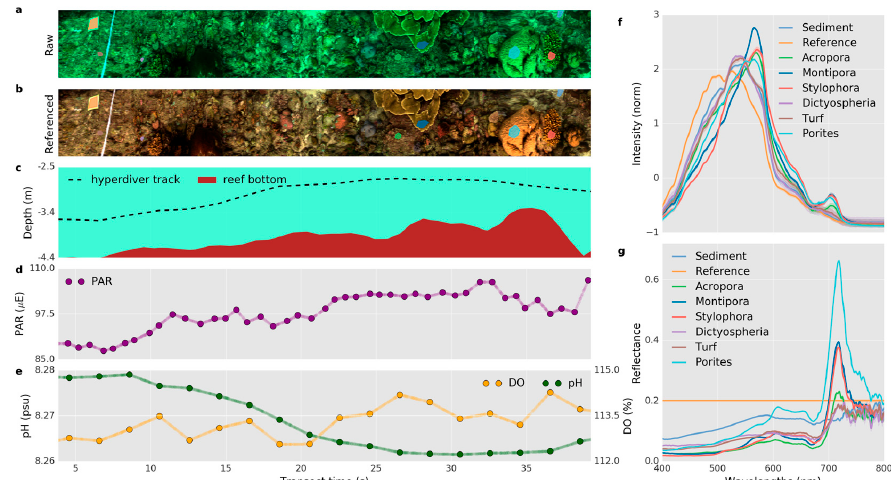
Figure 4. A multi-faced dataset from HyperDiver. ( a ) Three-channel color image; ( b ) a true-color image after correction; ( c ) depth and altitude information; ( d ) the photosynthetically active radiation (PAR) intensity; ( e ) dissolved oxygen and pH over the transect; ( f ) the average spectral intensity; and ( g ) the spectral reflectance of targets. Reprinted from Chennu et al. [36].